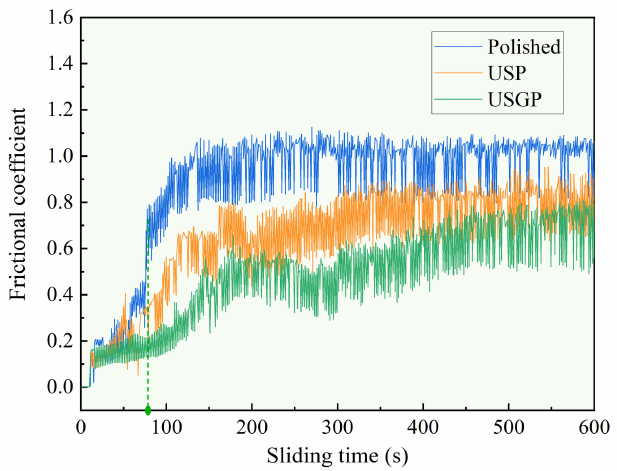
Figure 13. Variations of frictional coefficient for USGP, USP, and polished samples with the sliding time of 600